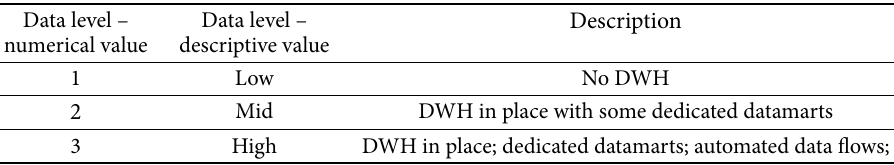
Table 2. Data level of sophistication